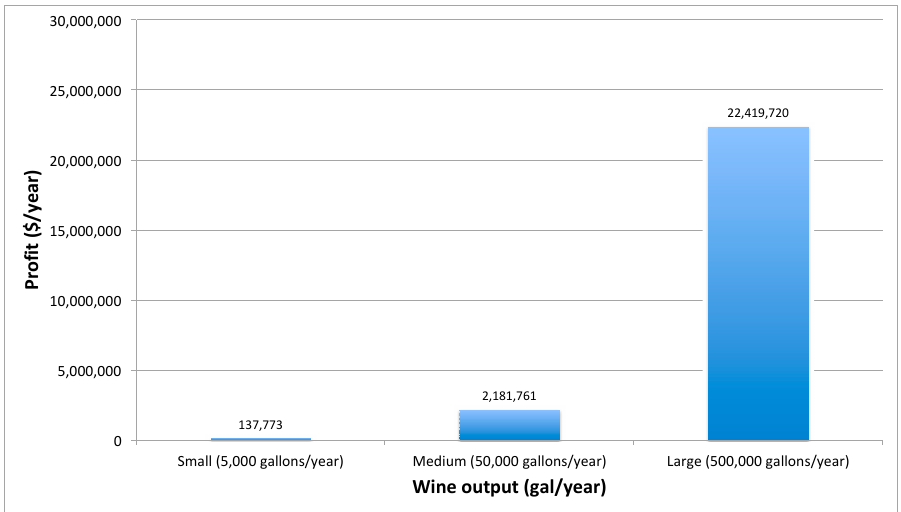
Figure 10. Annual net profit according to scale of operation.